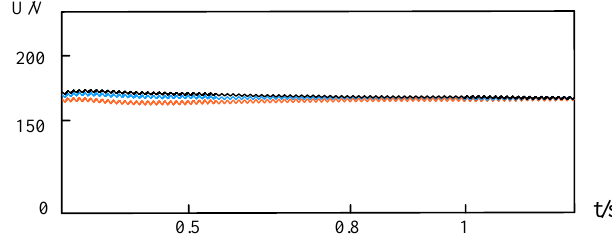
Figure 12. Reference 8 voltage balance control strategy.